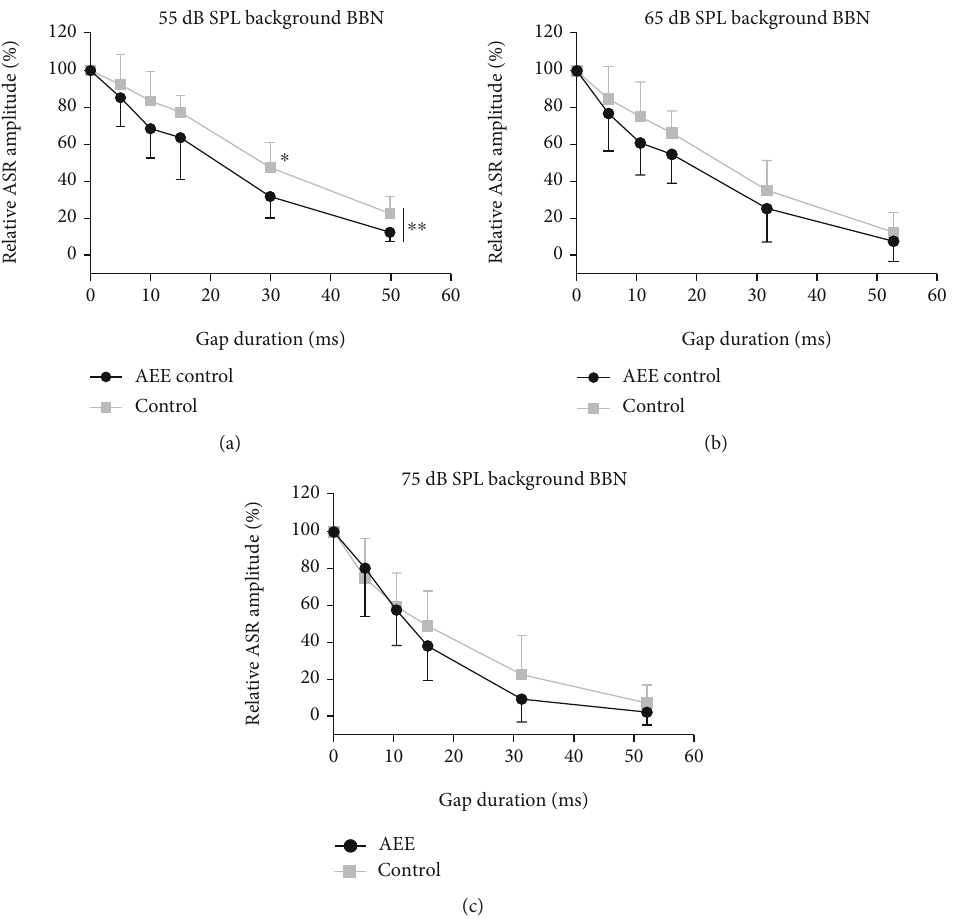
Figure 4: Comparison of the PPI of ASR induced by gaps of di ff erent durations in enriched and control animals ( mean ± SD ) at 55dB SPL (a), 65dB SPL (b), and 75 dB SPL (c) of background BBN; 100% corresponds to the amplitude of ASR without gap prepulse; smaller values of ASR amplitude ratio indicate stronger gap-PPI. Statistical signi fi cance: (a) ∗ p < 0 : 05 and ∗∗ p < 0 : 01 ; (b) p = 0 : 06 ; (c) p = 0 : 38 , RM two-way ANOVA with the Bonferroni